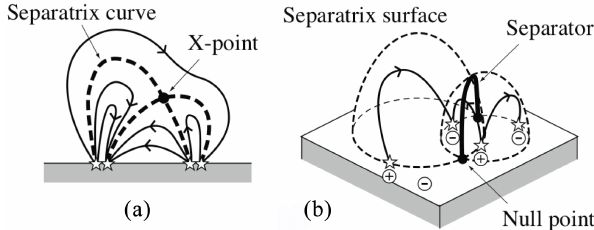
Figure 6. (a) The structure in 2-D near an X-type null point due to four sources on the base, showing how separatrix curves linking the X-point separate the 2-D region into topologically separate regions. (b) The structure in 3-D due to four sources on the base, showing how separatrix surfaces linking two null points (also on the base) separate the 3-D region into topologically separate volumes. The two separatrices intersect in a special field line called a separator that joins the one null point to the other.